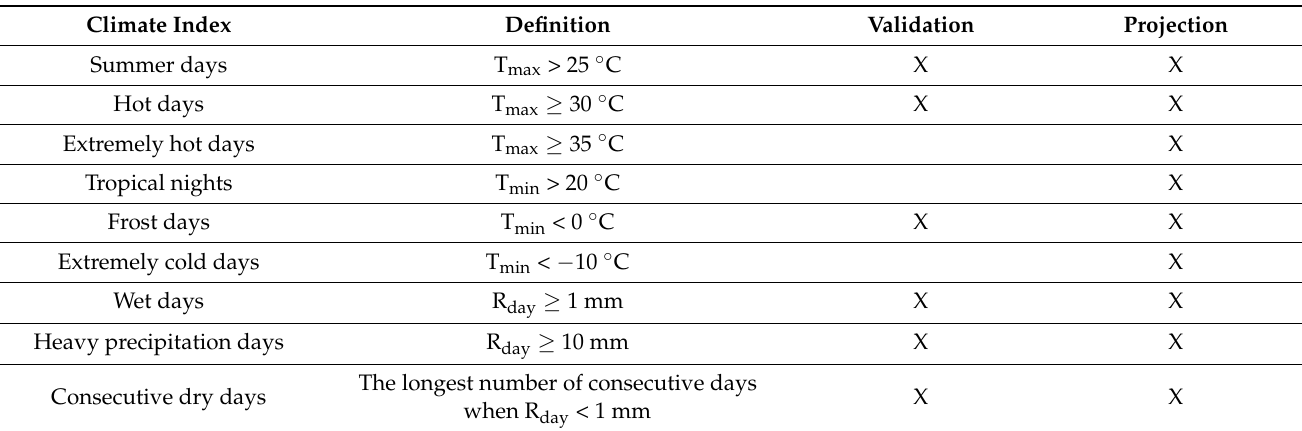
Table 3. Calculated climate